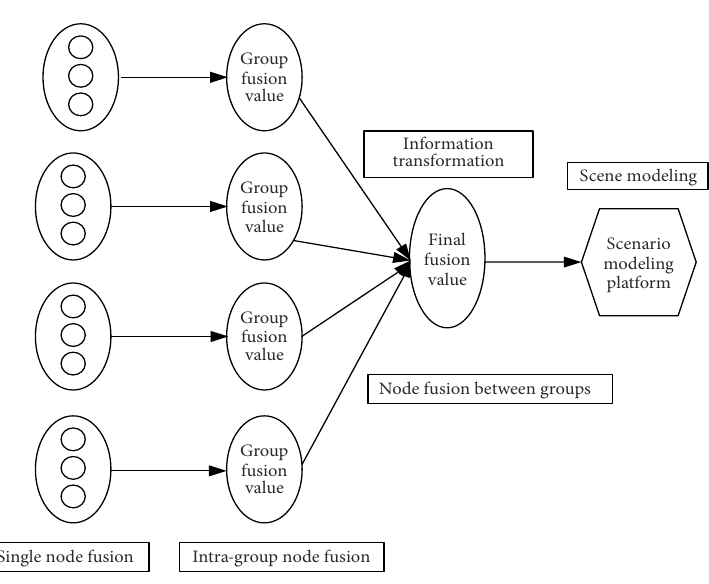
Figure 2. Structure of the data fusion of the proposed algorithm